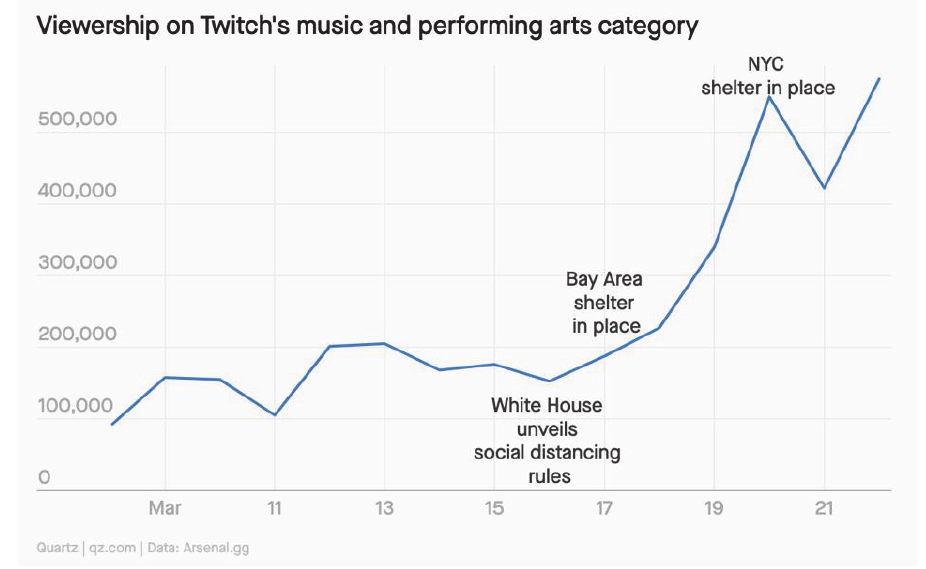
<Figure 2> Viewership on Twitch’s music and performing arts